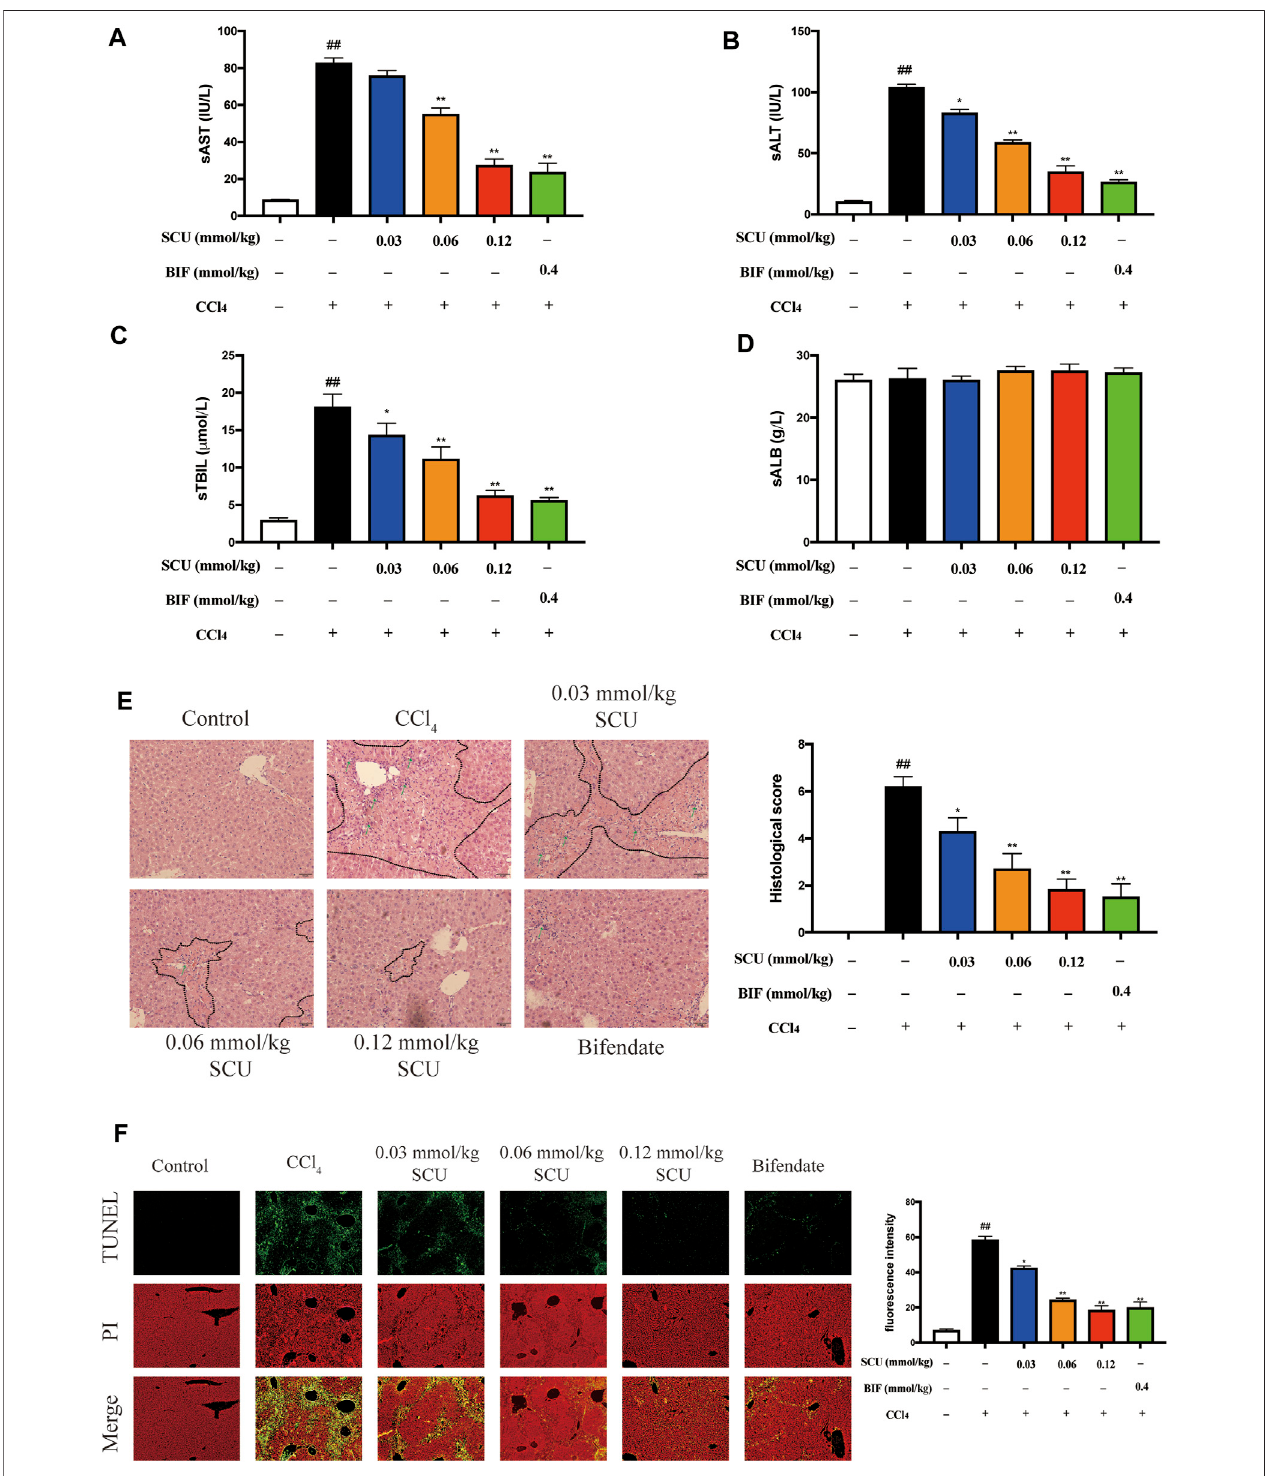
FIGURE 2 | SCU protected against CCl4-induced liver injury in mice. Serum ( A) AST, (B) ALT, (C) TBIL, and (D) ALB levels. (E) H and E staining (dotted line parts represent the necrosis area; arrows represent the in fl ammatory cell in fi ltration). (F) TUNEL staining. Scale bar 50 μ m, magni fi cation 200 × . ( n (cid:1) 5). ## p < 0.01 vs. control group; * p < 0.05, ** p < 0.01 vs. CCl 4 group.